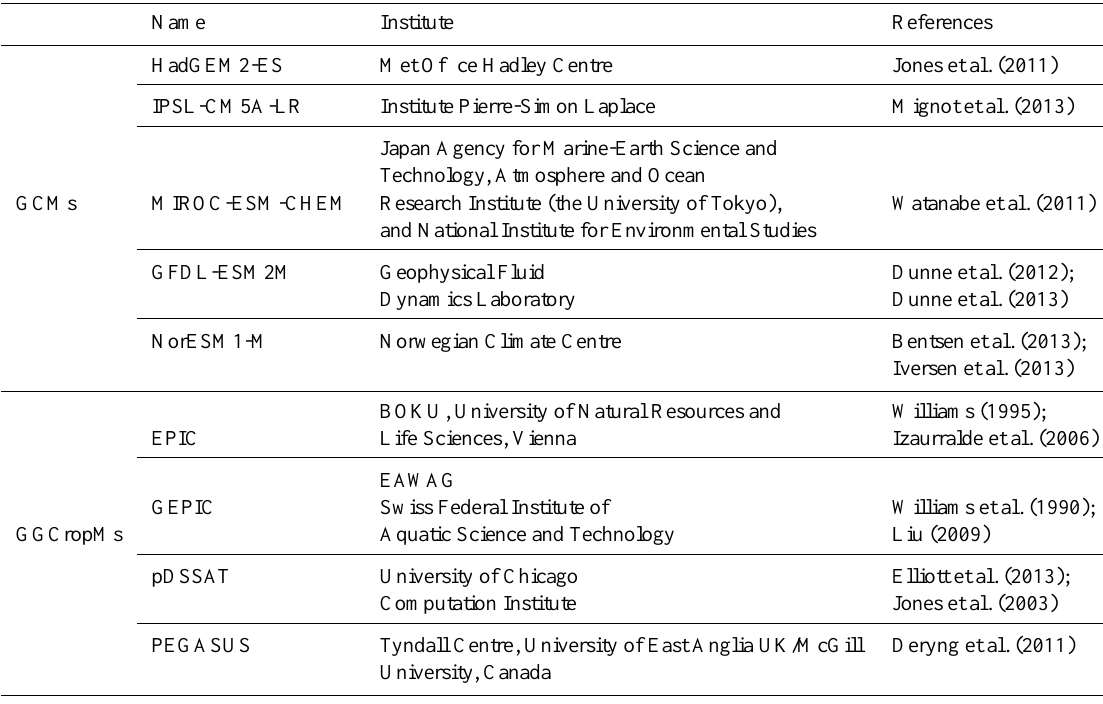
Table 1. Overview of the GCMs and